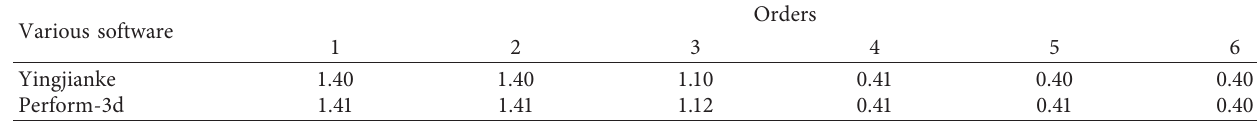
Table 3: The first 6-order period of the